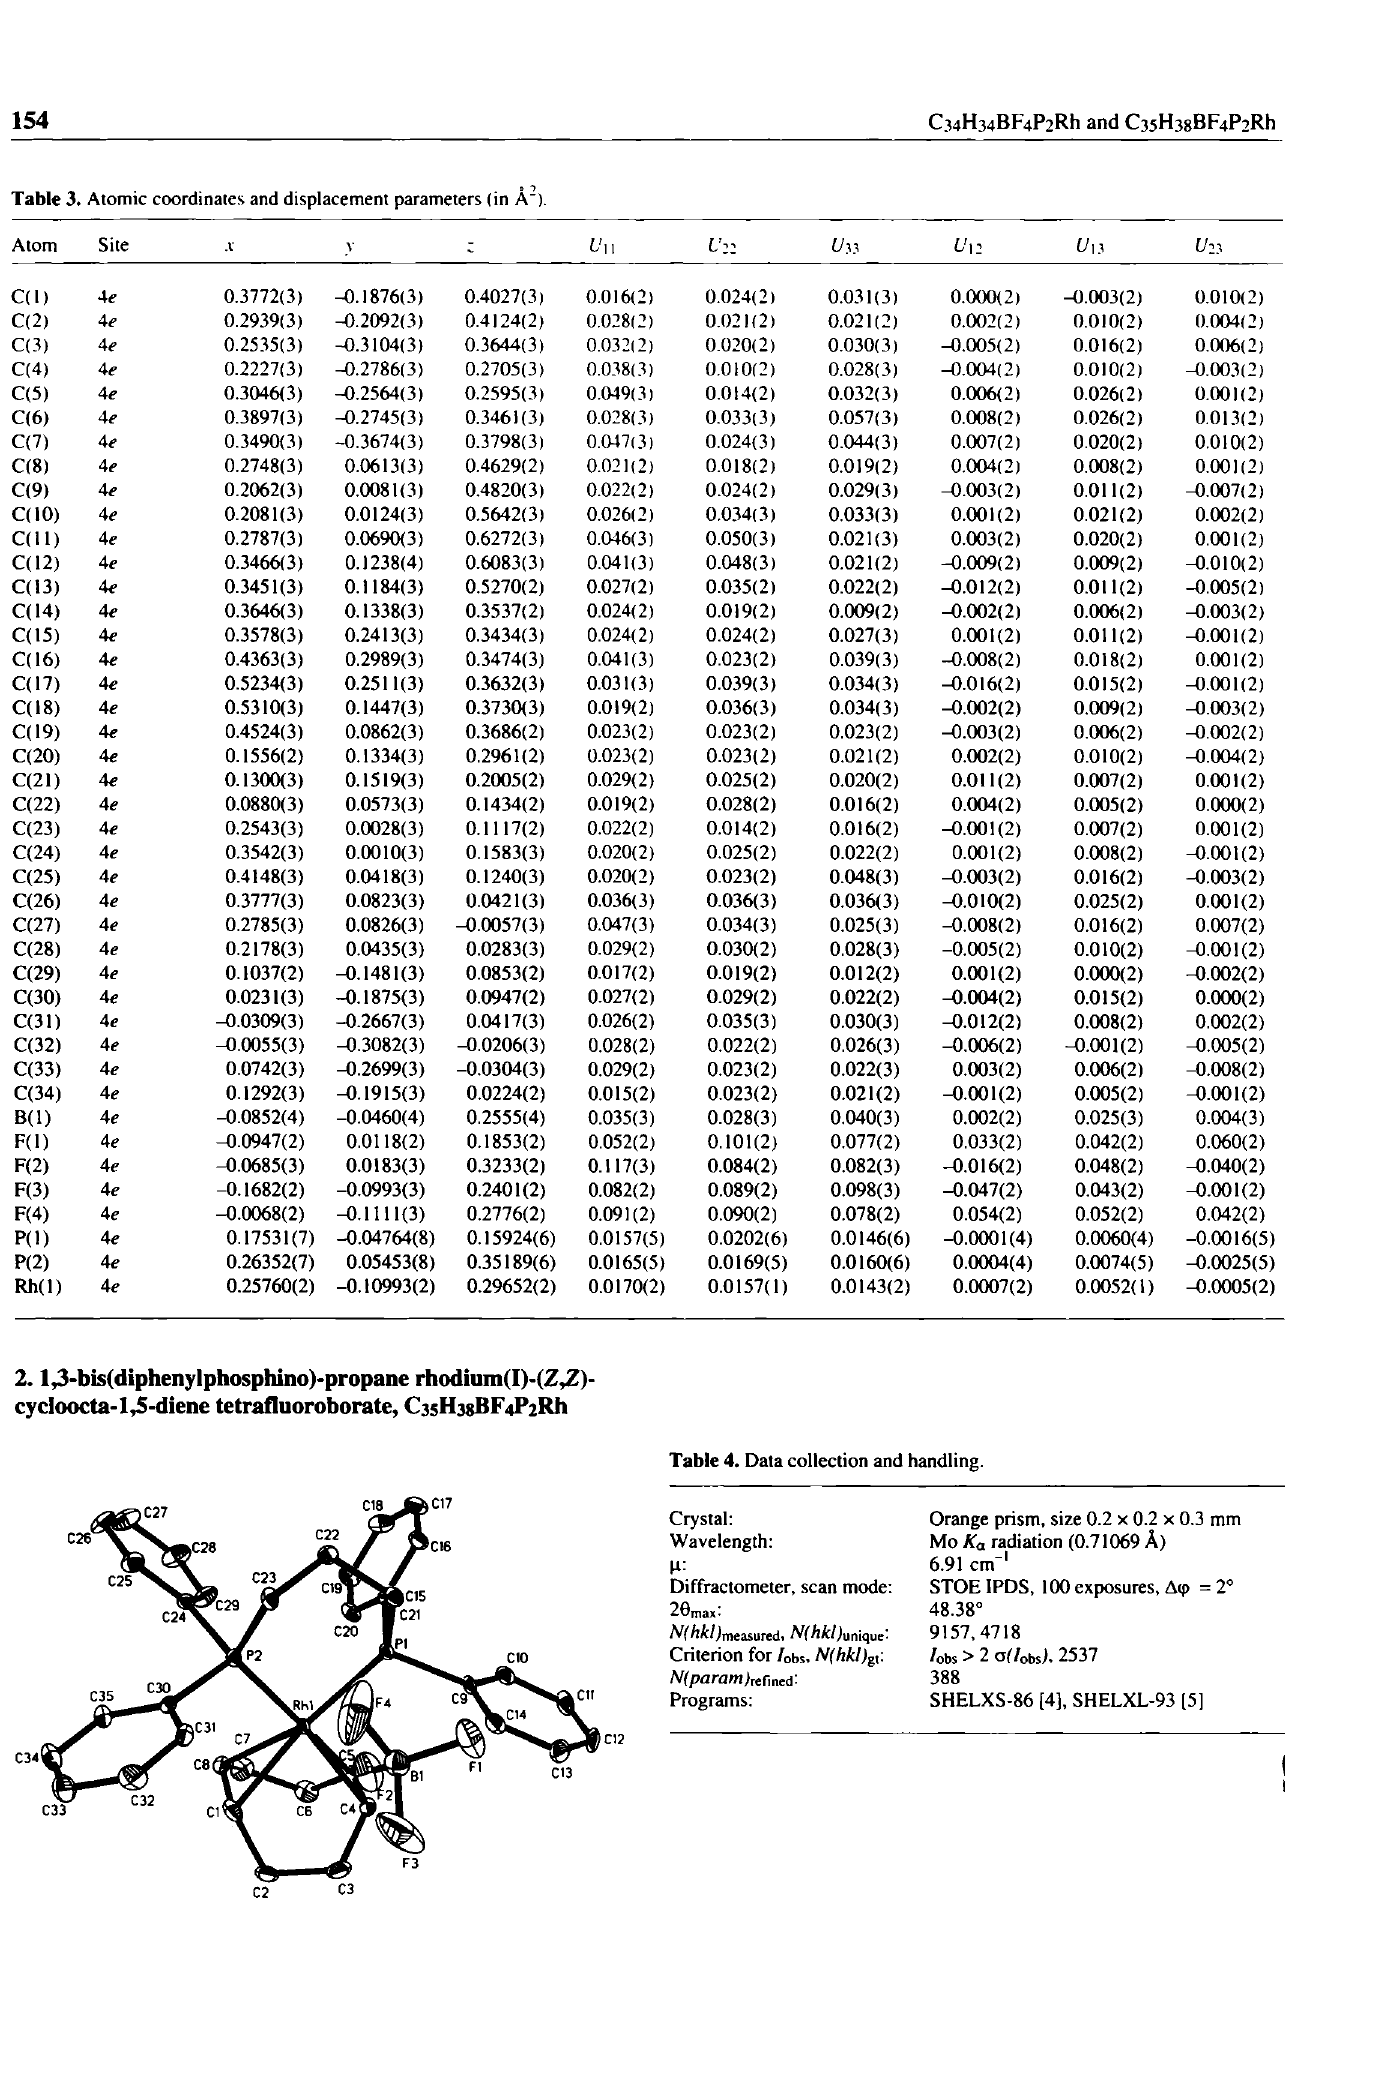
Table 3. Atomic coordinates and displacement parameters (in A"). Atom Site